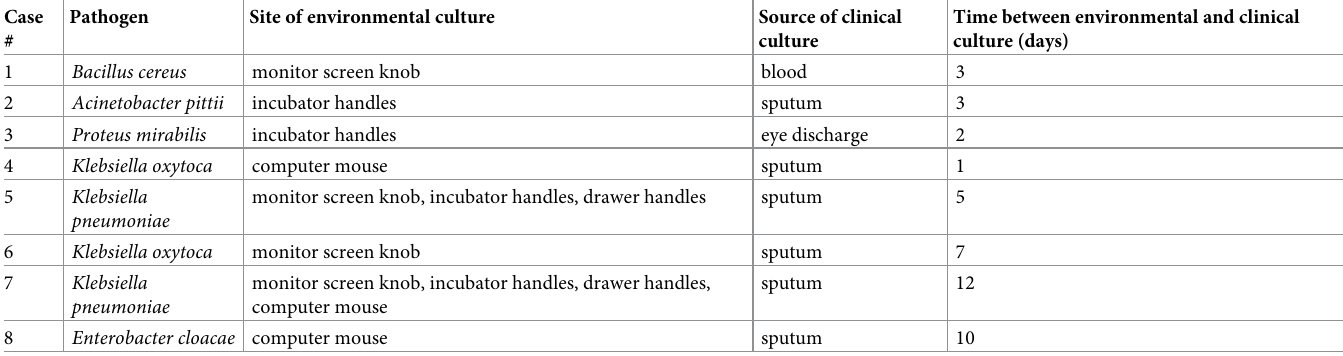
Table 1. Correlation of time and site between clinical and environmental cultures during the study